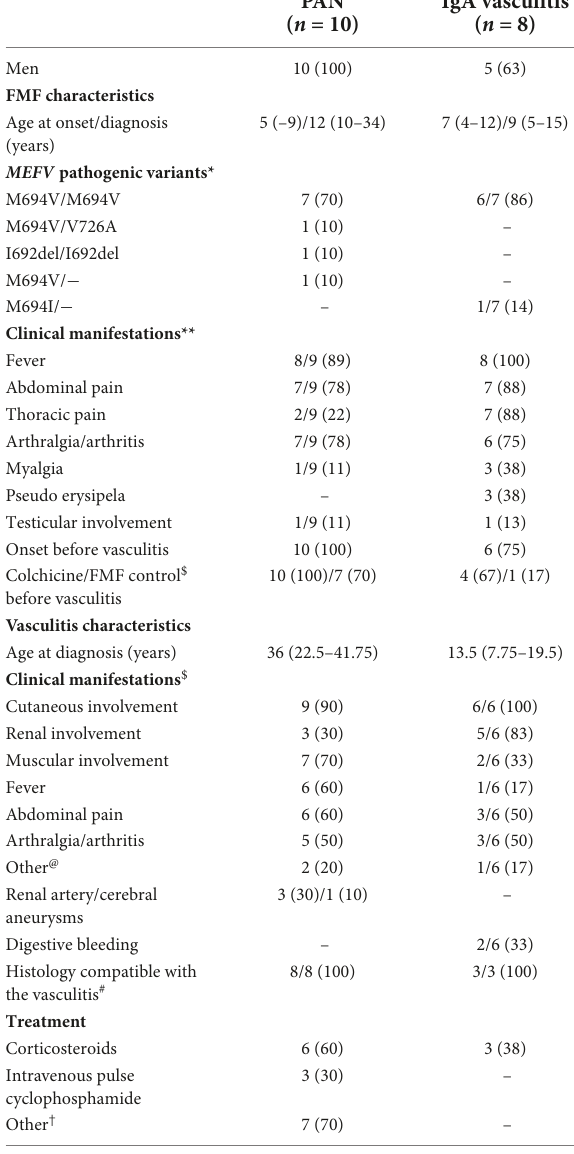
TABLE 1 Main characteristics of patients with FMF-associated PAN and IgA